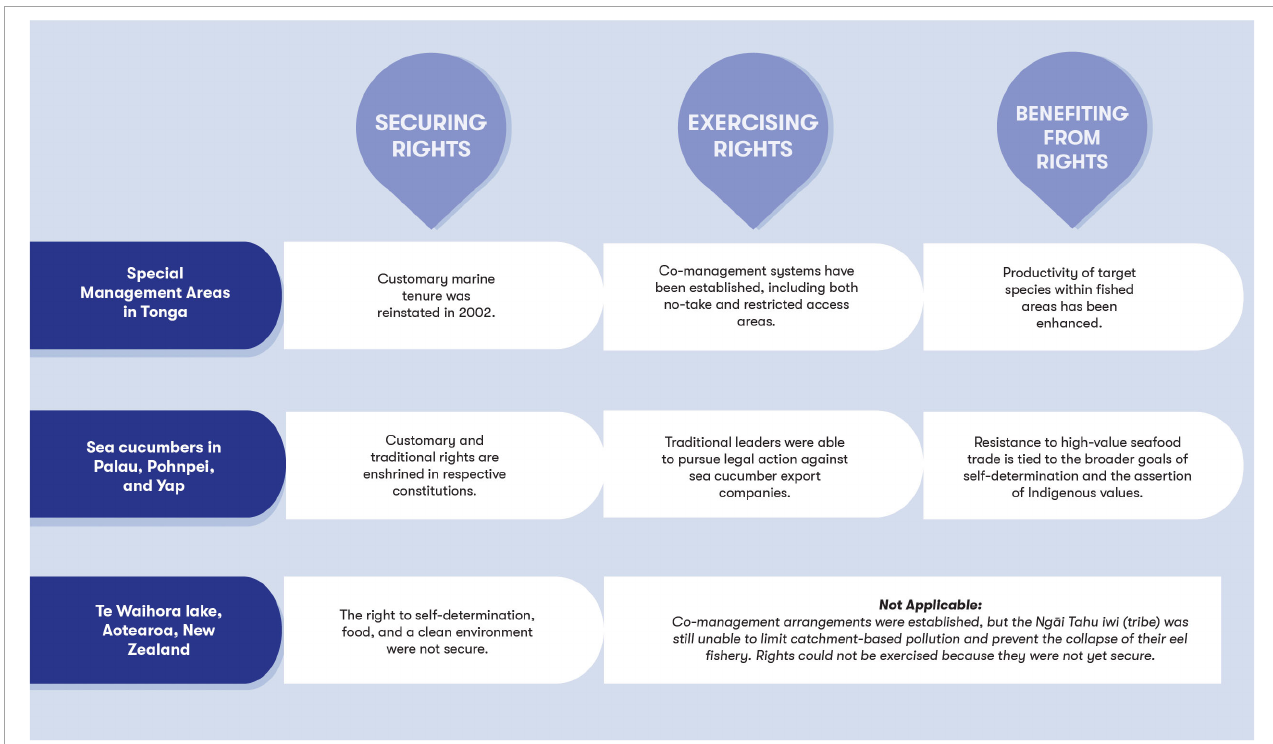
TABLE 5 Examples of sequential investments in human rights and marine